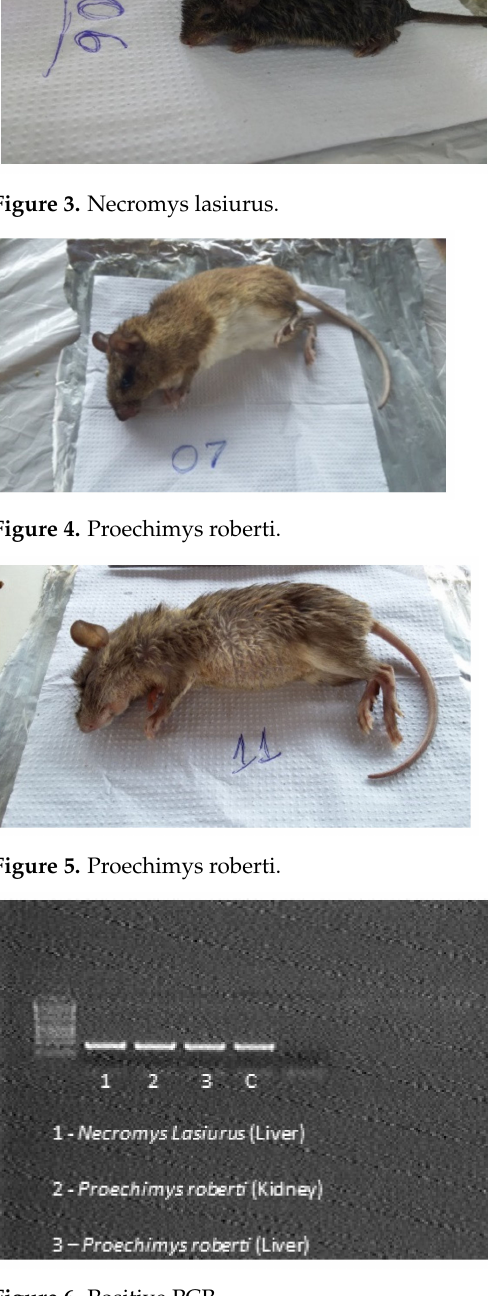
Figure 6. Positive